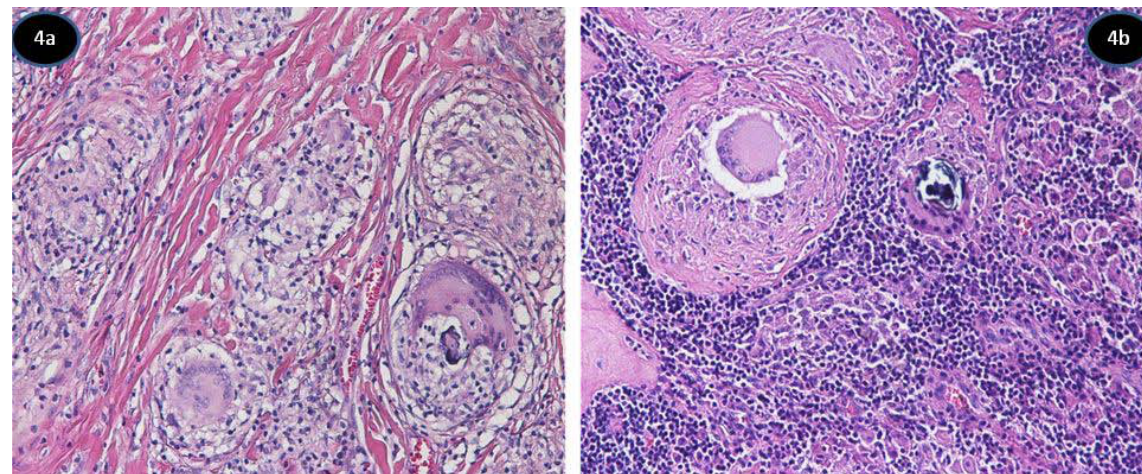
Figure 4. A) Breast lesion consisting of confluent non-caseating granulomas, H-E X 200. B) Lymph node with granulomas and a Schaumann body in the cytoplasm of a giant cell H-E X